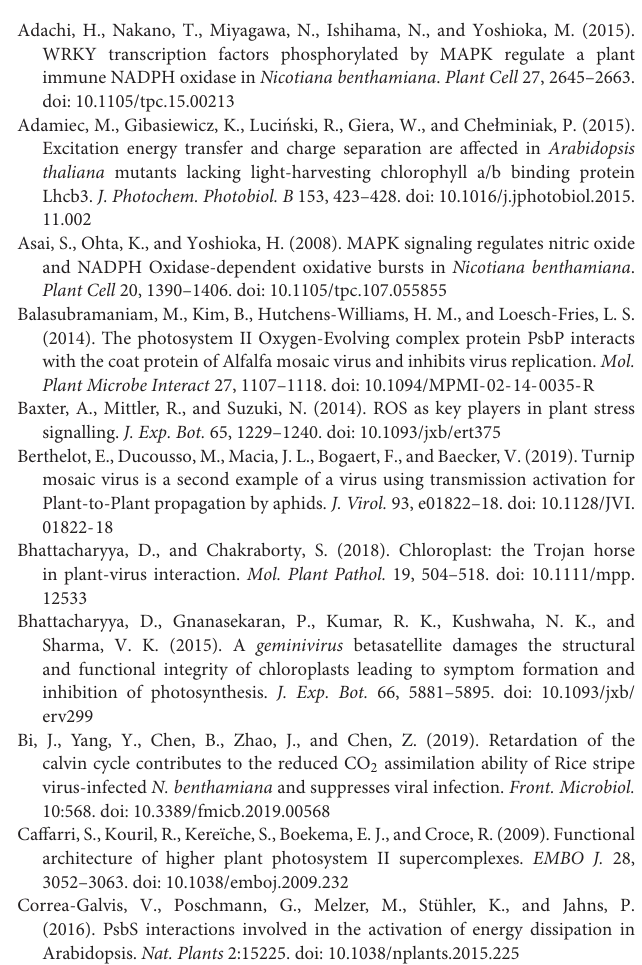
means from three biological repeats. A two-sample unequal variance directional Student’s t -test was used to test the significance of the differences ( ∗ P < 0.05). Supplementary Figure 3 | Northern blotting showing the accumulation of TuMV-GFP RNAs at 5 dpi in the plants where NbLHCB3 was co-silenced with individual genes in the ROS production pathway, AO , RBOHA , RBOHB , RBOHC , and RBOHE . The relative intensity of the blot signal quantified by IMAGE J software is shown on the lanes. Supplementary Figure 4 | Northern blotting showing the accumulation of TuMV-GFP RNAs at 8 dpi in the plants where NbLHCB3 was co-silenced with individual genes in the ROS scavenging pathway, CAT , SOD(CuZn) , SOD(Fe) , SOD(Mn) , tAPX , GR1 & GR2 , and GR3 & GR4 . The relative intensity of the blot signal quantified by IMAGE J software is shown on the lanes. Supplementary Figure 5 | The expression of LHCB3 and genes in the ROS production and scavenging pathways were all downregulated in these co-silenced plants. (A–E) The expression of LHCB3 and genes in the ROS production pathway ( AO , RBOHA , RBOHB , RBOHC , and RBOHE ) were downregulated in these co-silenced plants. (F–L) The expression of LHCB3 and genes in the ROS scavenging pathway [ CAT , SOD(CuZn) , SOD(Fe) , SOD(Mn) , tAPX , GR1&GR2 , and GR3&GR4 ] were downregulated in these co-silenced plants. Supplementary Table 1 | Primers used in the experiments. Supplementary Table 2 | Accession numbers of Nicotiana benthamiana